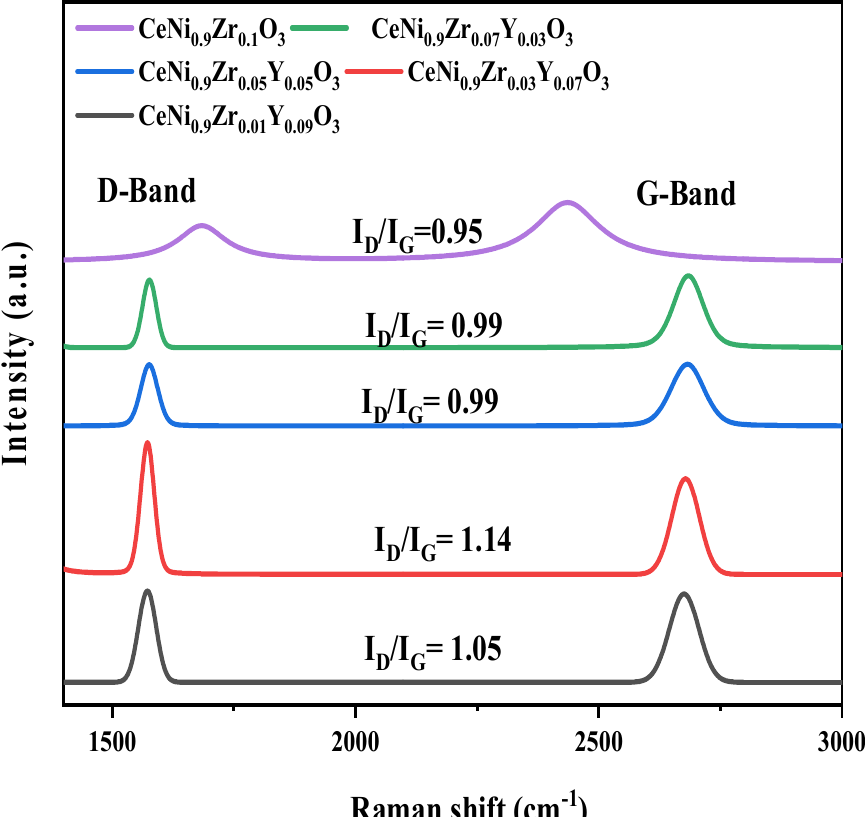
Figure 11. Raman Spectra of Used Perovskite Catalyst CeNi 0.9 Zr 0.1 − x Y x O 3 ( x = 0.03, 0.05, 0.07, and 0.09).